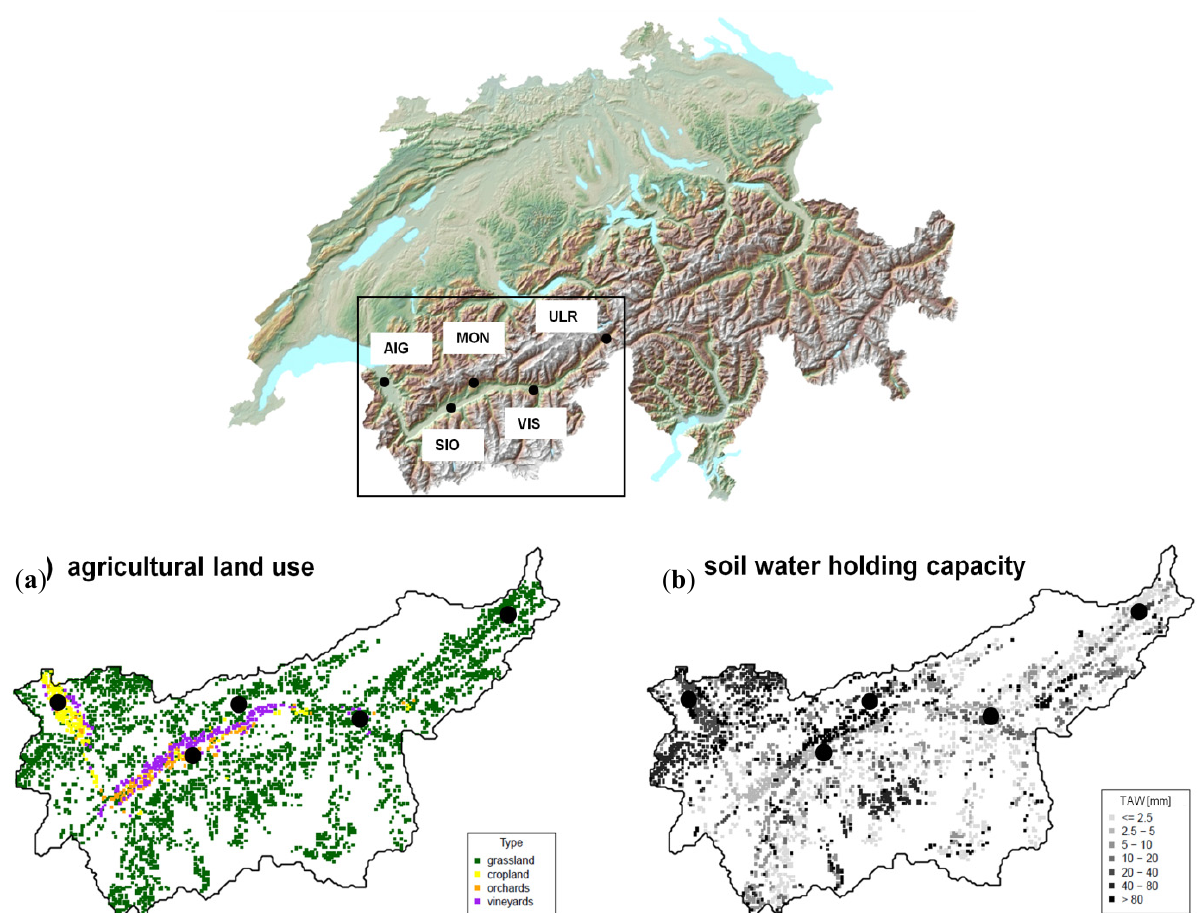
Figure 1. ( Top ) Map of Switzerland showing the location of the Canton Valais, Rhone catchment and the five sites selected for the modeling tool calibration. Coordinates and acronyms of the latter are given in Table 1; ( Bottom ) ( a ) Agricultural land use type; ( b ) Water holding capacity of the soil (TAW).